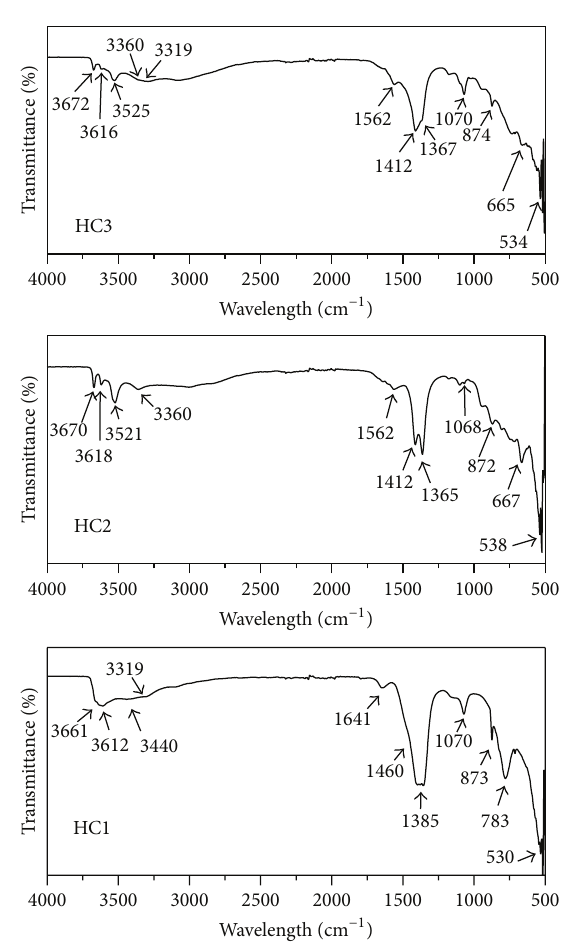
Figure 3: FTIR spectra of the pristine